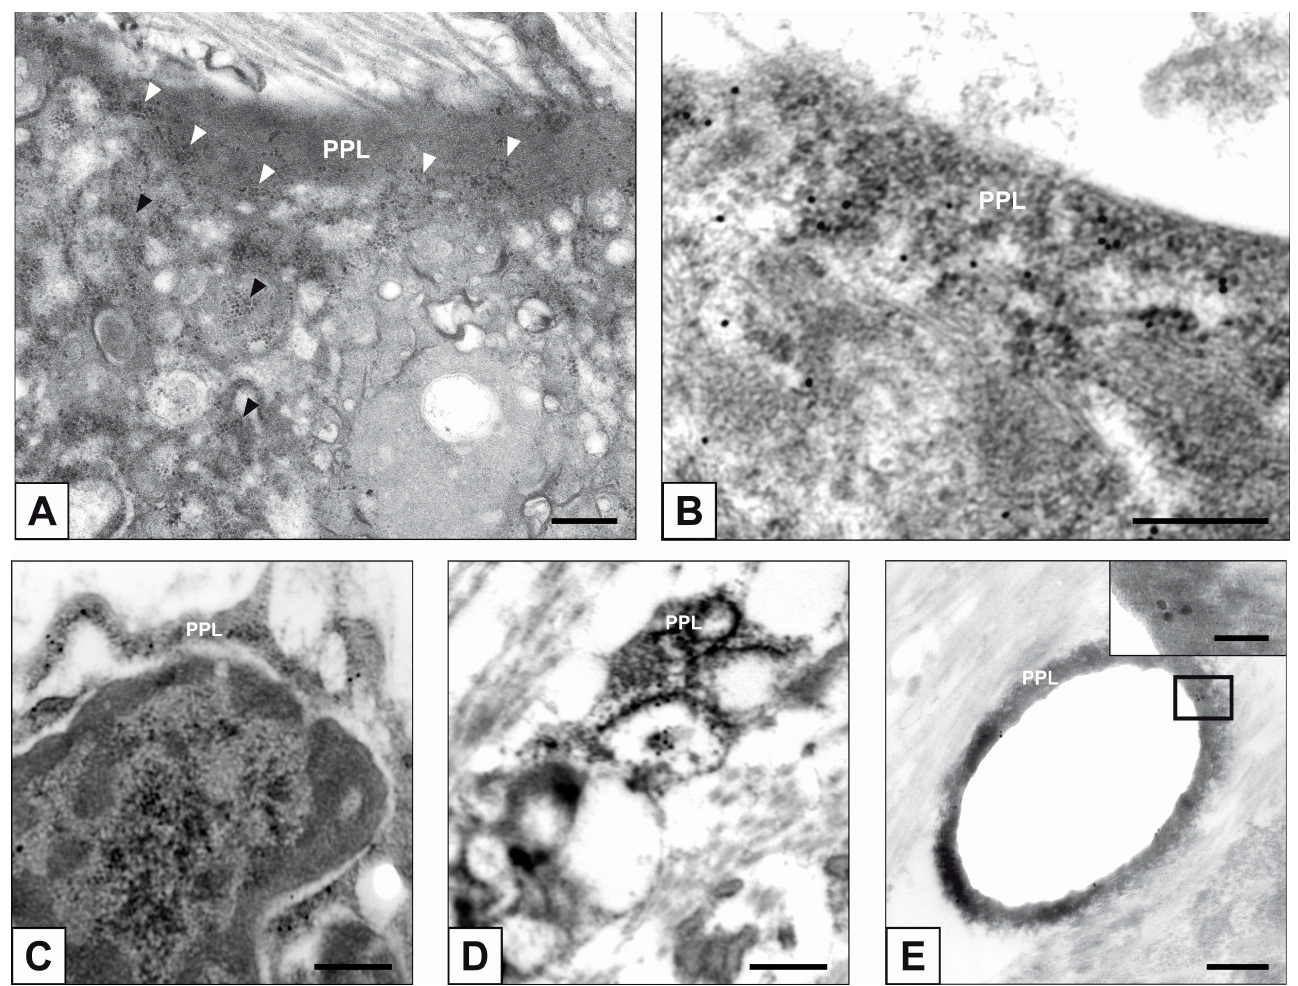
Figure 6. Ultrastructure of AVICs populating stenotic hAVLs. ( A ) Ribosomes (black/white arrowheads) embedded within PPM/PPL in a mineralizing hAVIC. ( B , C ) Immunogold labelling of rRNA with gold particles decorating peripheral PPLs. ( D ) Immunogold labelling of rRNA showing gold particles within PPM/PPLs in a hAVIC undergone advanced calcific degeneration. ( E ) Immunogold labelling of rRNA showing gold particles onto a PPL lining a vesicle-shaped cell byproduct. Inset: magnification of the PPL-squared region. Bar: 0.25 μ m ( A – E ); 0.1 μ m (( E ) inset.